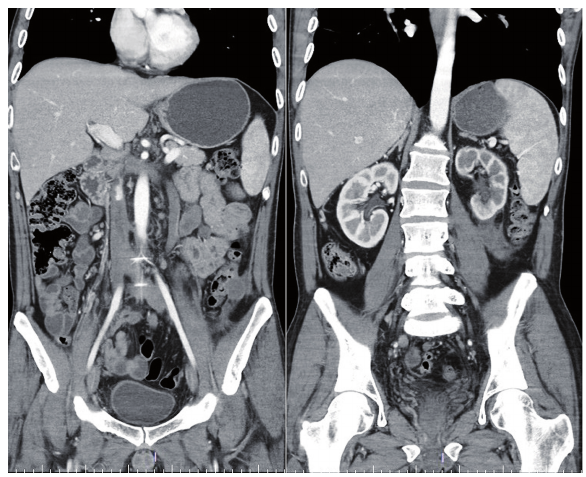
figure 2 - computerized tomography scan of the abdomen demonstrating the inferior vena cava thrombus extended from the left spermatic vein and bilateral external iliac veins to the hepatic vein, no evidence of metastasis, and the improvement of the left renal function at 3 months after the